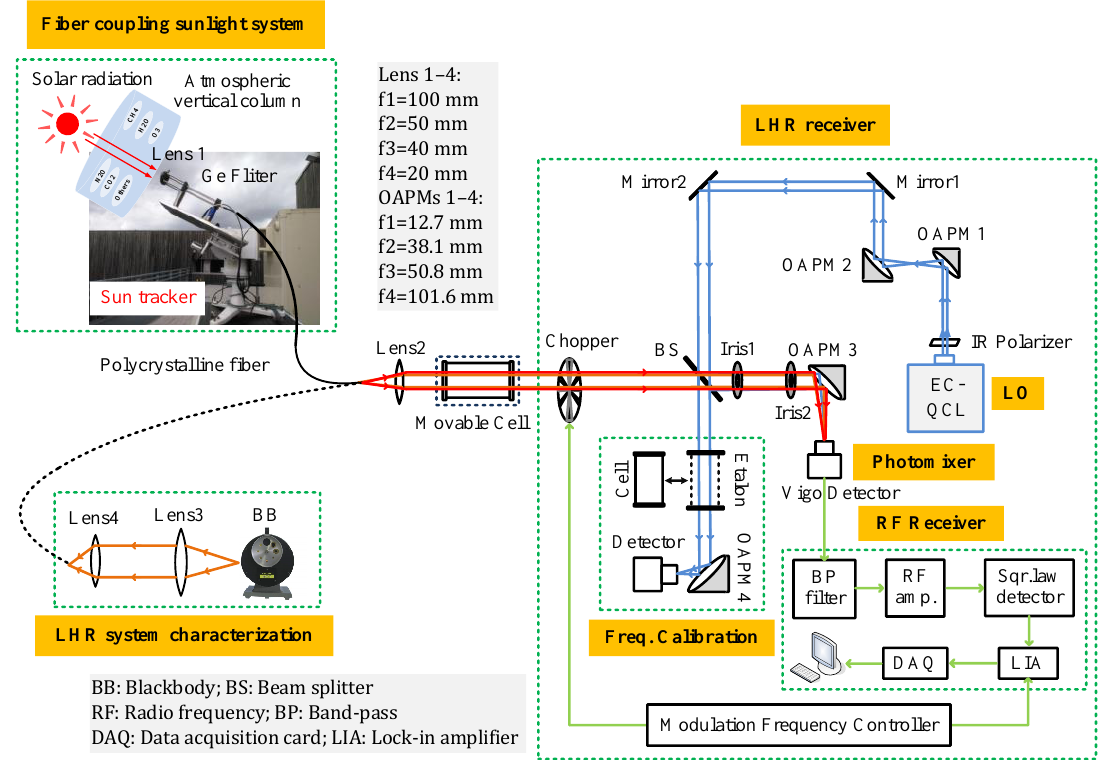
Figure 1. Schematic of a fully transportable LHR involving a PIR fiber-coupling solar or BB radiation system.